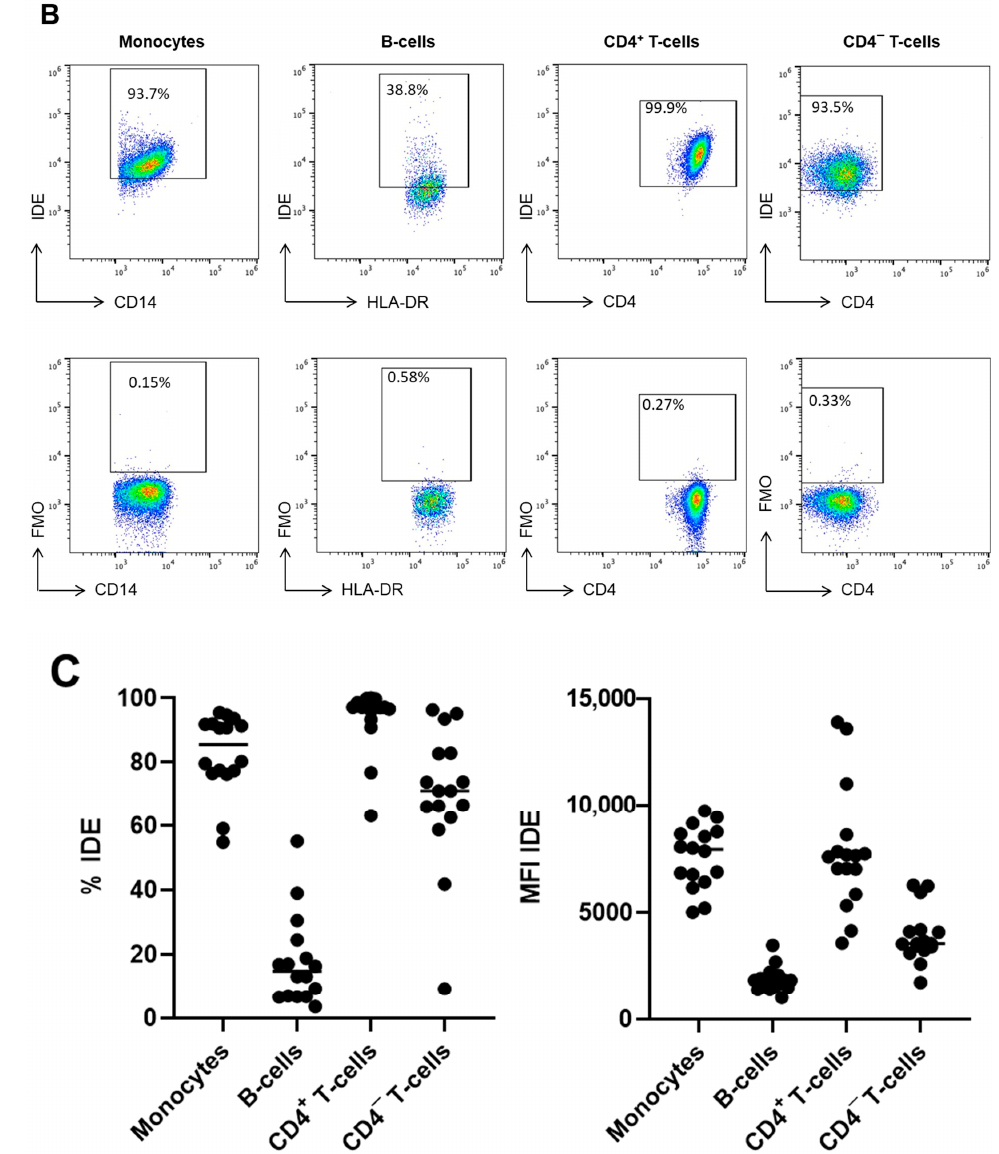
Figure 2. IDE surface expression on human peripheral blood mononuclear cell subsets. ( A ) Peripheral blood mononuclear cells from healthy controls were stained with several surface markers and identified within singlet viable leukocytes (CD45 + ). Monocytes were identified as HLA-DR + CD14 + . Within the non-monocyte fraction, B-cells were identified as HLA-DR + CD19 + cells, while T-cells were defined by the expression of CD3 and further divided into CD4 + and CD4 − cells. ( B ) IDE expression was determined within each subset and compared to the fluorescence minus one (FMO) control. The pooled data of from several independent experiments displaying the different IDE levels of expression between the different subsets are shown in ( C ) as percentages of positive cells or as median fluorescence intensities